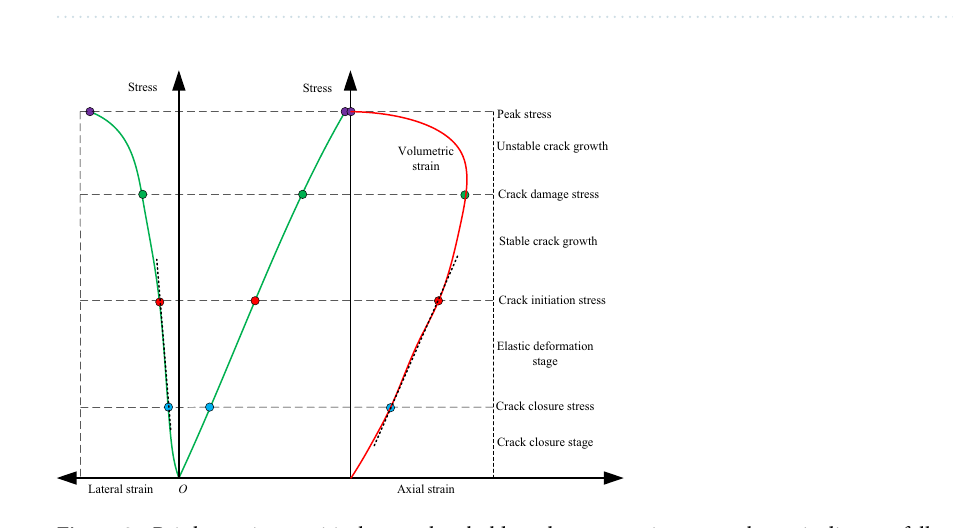
Figure 8. Brittle specimen critical stress thresholds and stress–strain curve schematic diagram following the addition of uniaxial compression 31